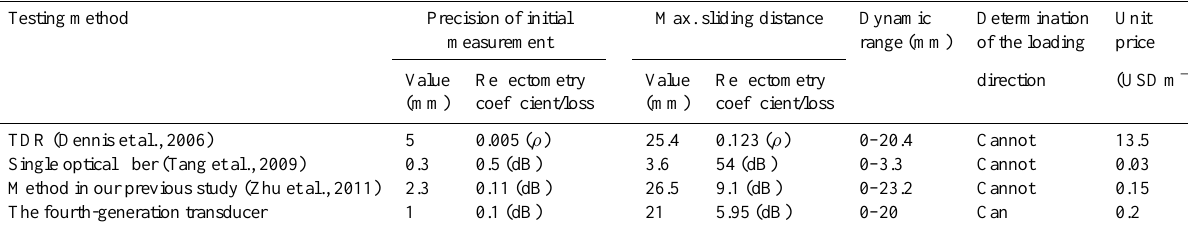
Table 5. Comparison of the present model with other monitoring models. Testing